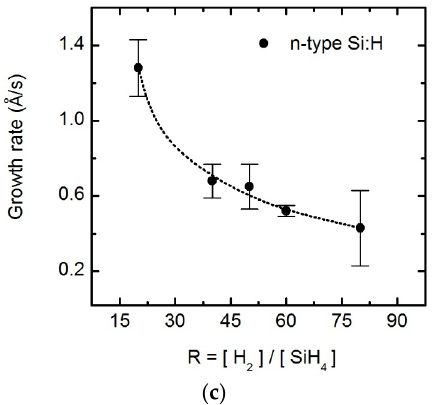
Figure 7. Deposition rates of ( a ) n ‐ , ( b ) i ‐ , and ( c ) p ‐ layers on ZnO/Ag, n ‐ layer/ZnO/Ag, and i ‐ layer/glass, respectively, as functions of R .